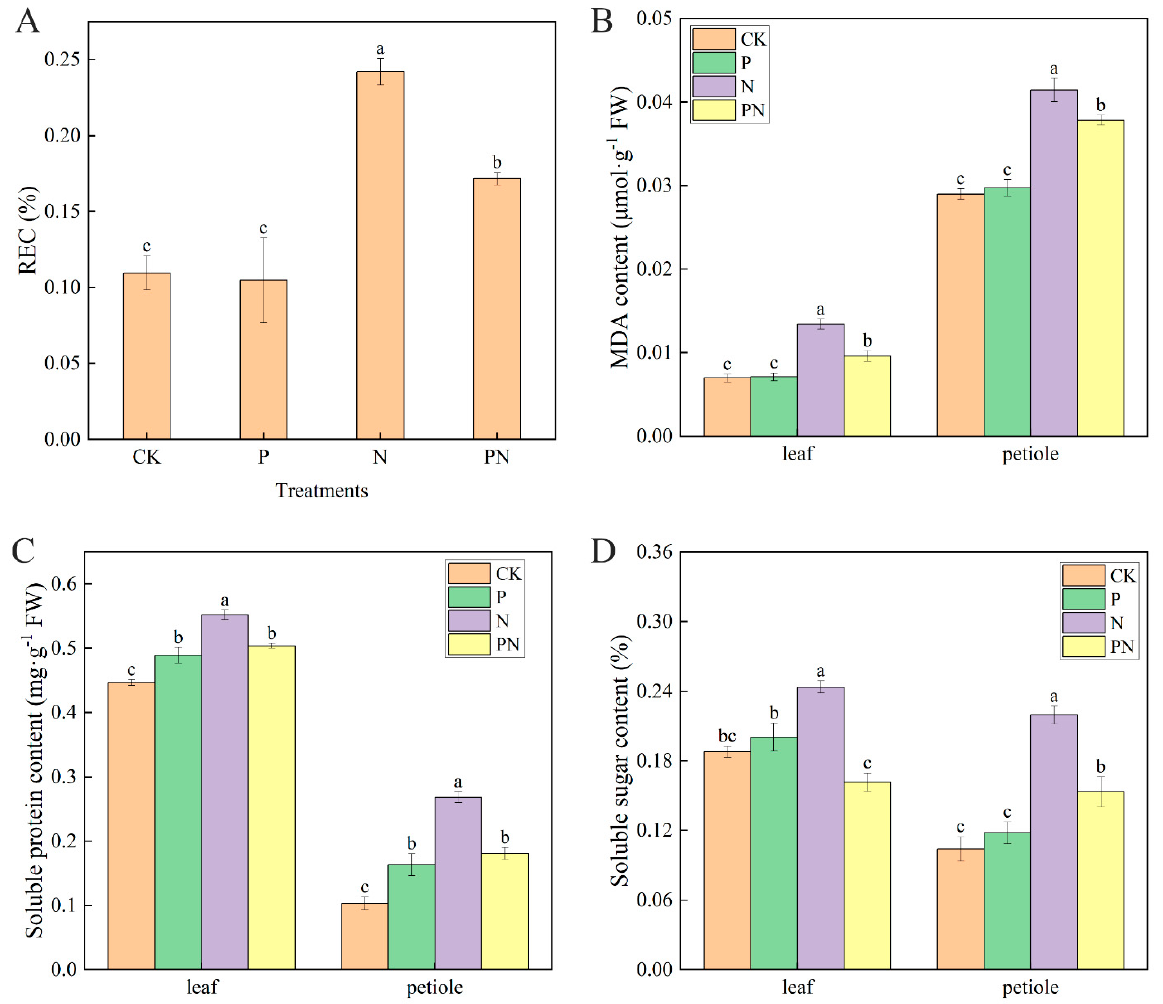
Figure 5. Effect of proline on cell membrane damage and osmotic substance content in celery under salt stress. After planting the 35-day-old seedlings for 7 days, they were treated with 0.3 mM proline solution for 7 days, after which they were watered with 100 mM NaCl solution thrice every 3 days. ( A ) Relative conductivity (REC). ( B ) Malondialdehyde (MDA) content. ( C ) Soluble protein content. ( D ) Soluble sugar content. The results are expressed as the mean ± SE of three replicates, and the different letters denote the significant difference among treatments ( p < 0.05), according to Duncan’s multiple tests. CK, control. P, 0.3 mM proline. N, 100 mM NaCl. PN, 100 mM NaCl+ 0.3 mM proline.